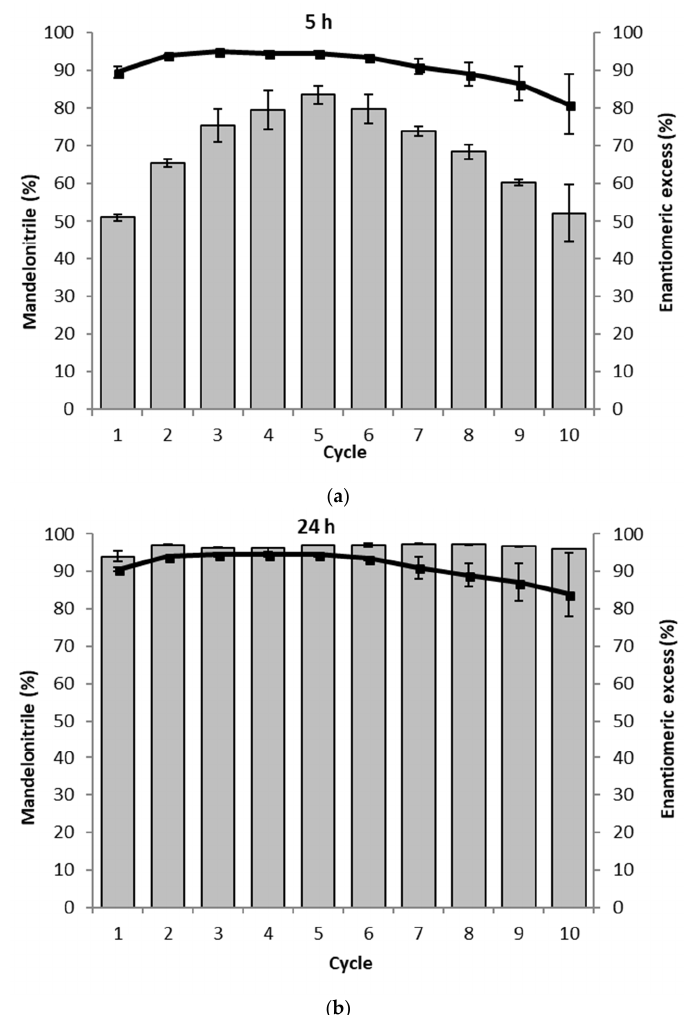
Figure 4. The recycling of the Pa HNL immobilized on Celite in ten successive mandelonitrile synthesis reactions. The assay was performed in duplo and the average of both results is shown. The gray bars represent the conversion to mandelonitrile (%) and ■ and the solid line represent the enantiomeric excess (%). Conditions: benzaldehyde (±106 mg, 1 mmol), 2 mL ∙ HCN solution in MTBE (1.5 M), 1,3,5 ‐ triisopropylbenzene (±25 mg, internal standard) and a small, tightly packed teabag filled with the Pa HNL immobilized on Celite R-633 (6.5 U/mg; 50 mg), stirred at 900 rpm at room temperature. Remarks: before the reaction of cycle 6, the teabag was stored in the fridge over the weekend. ( a )